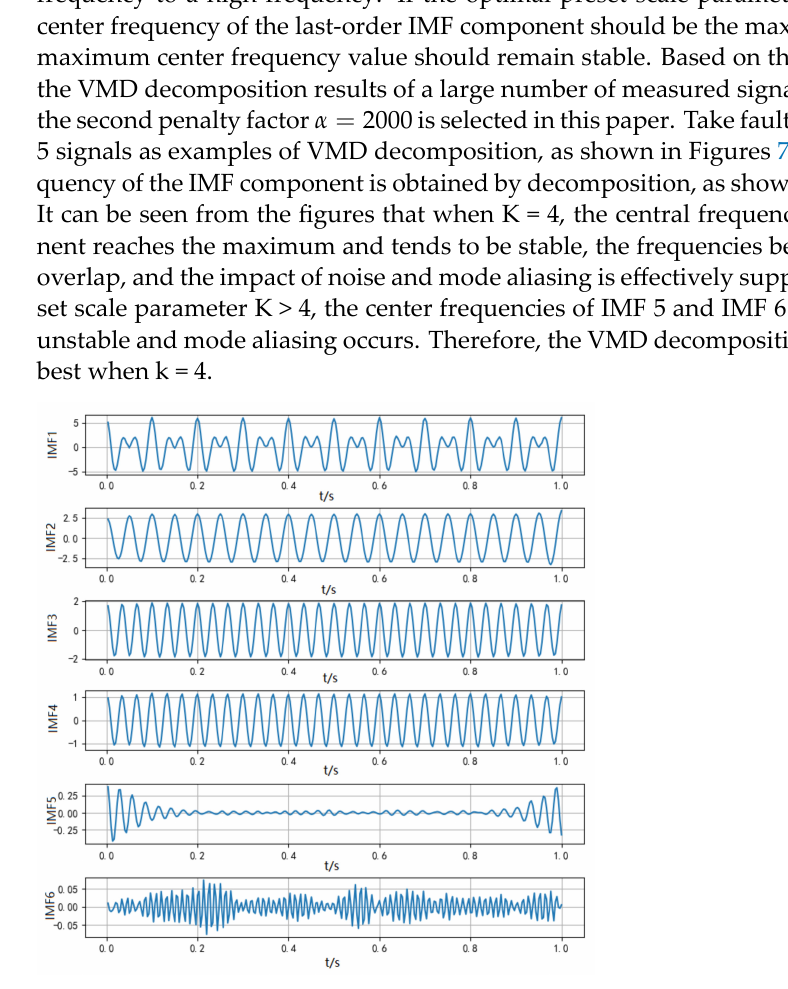
Figure 7. VMD Decomposition Sequence Diagram of Fault 3